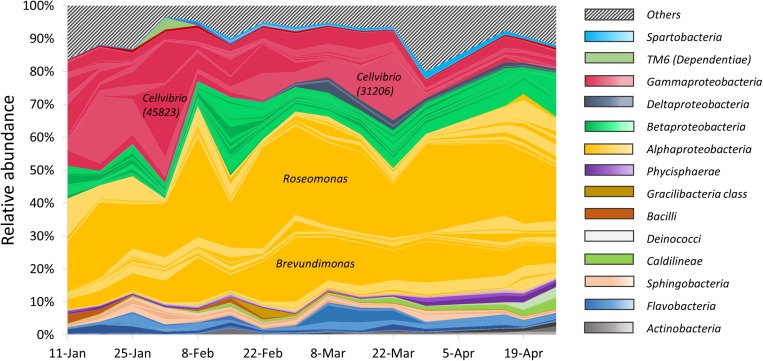
Relative abundance of particle-associated heterotrophic bacteria at class level obtained from 16S rRNA gene sequencing. Colored areas represent the 100 most abundant OTUs. Each colored line represents a single OTU. Striped area represents the rest of the heterotrophic OTUs.